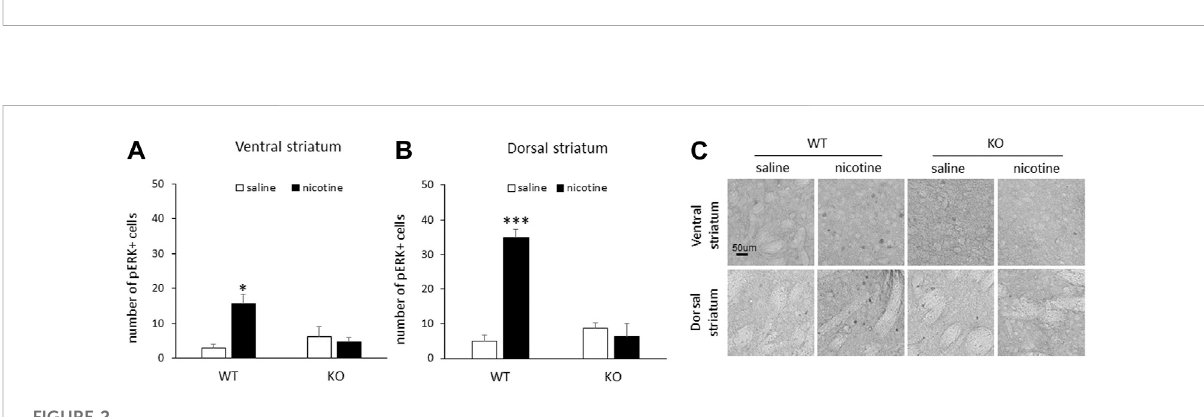
FIGURE 1 Acute nicotine increased striatal pERK in male C57Bl6/N mice. (A) An acute injection of nicotine (0.4 mg/kg IP) resulted in a signi fi cant increase inthenumberofpERK1/2-positivecellsrelativetosalinecontrolsinthestriatum( n =5/group).DatarepresentthemeannumberofpERK1/2-positive cells (±SEM) in each condition in the ventral and dorsal striatum. (B) Representative slices showing pERK-positive cells from the ventral and dorsal striatum of male C57Bl6N mice that received acute nicotine or saline injections. * p < 0.05, main effect of treatment (nicotine relative to saline).